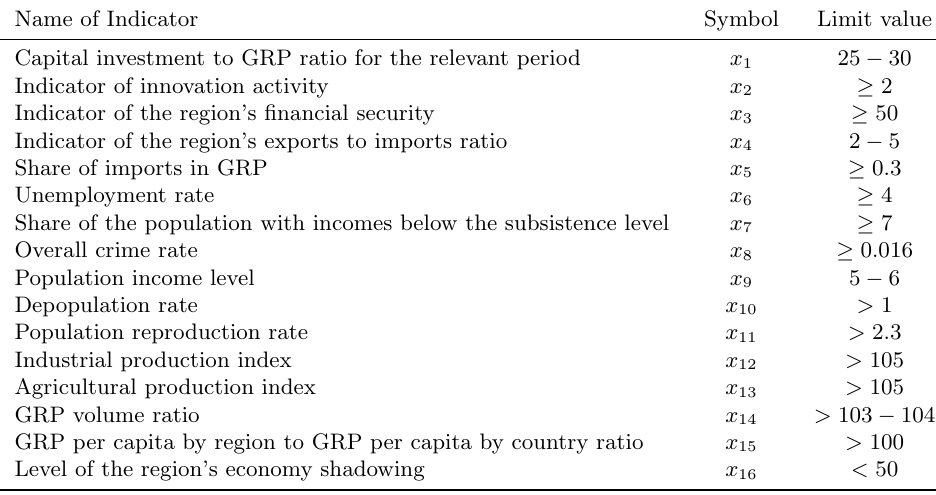
Table 3: Indicators (specific factors) for assessing the economic security of a